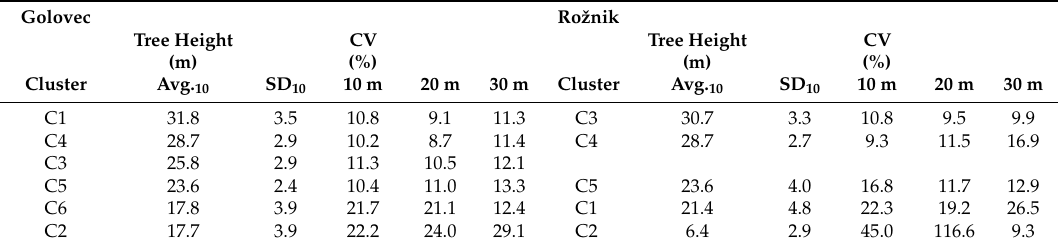
Figure 4. Determining optimal clusters on the forest edges in the study area of Nadgorica based on the data of the tallest trees and the proportion of canopy cover at different height levels of trees. Table 1. Forest edge height classes in different clusters based on the data of the tallest trees in the study area of Golovec and Rožnik.